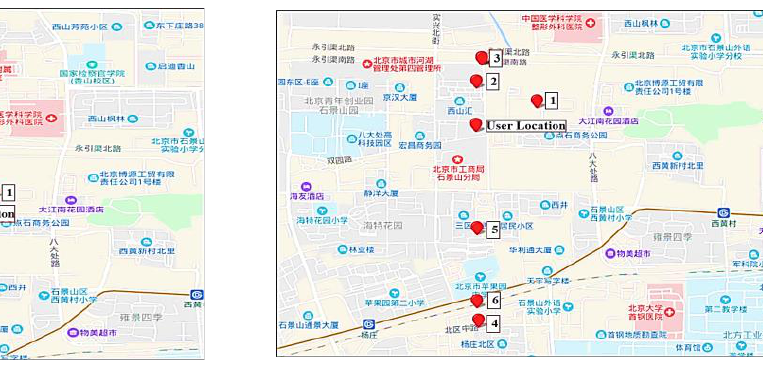
Figure 6. Example of spatial cloaking method.